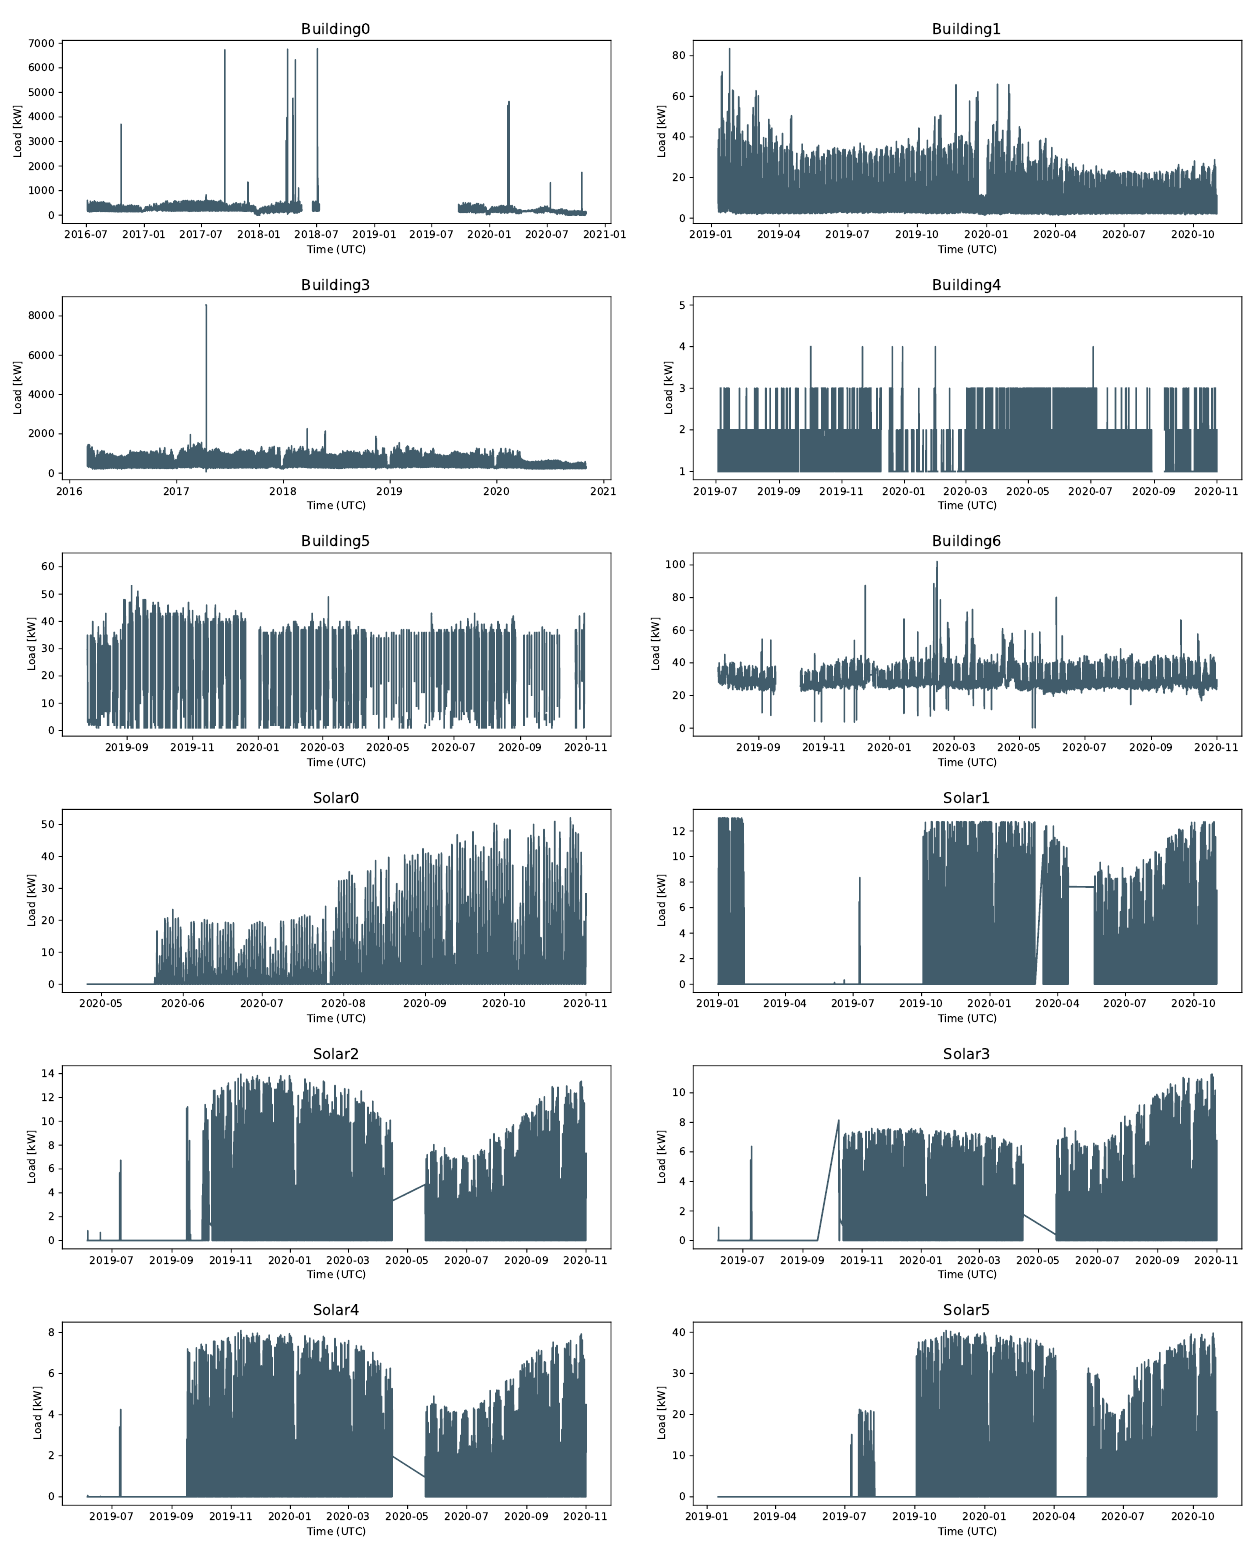
Figure 1. Historical load and production